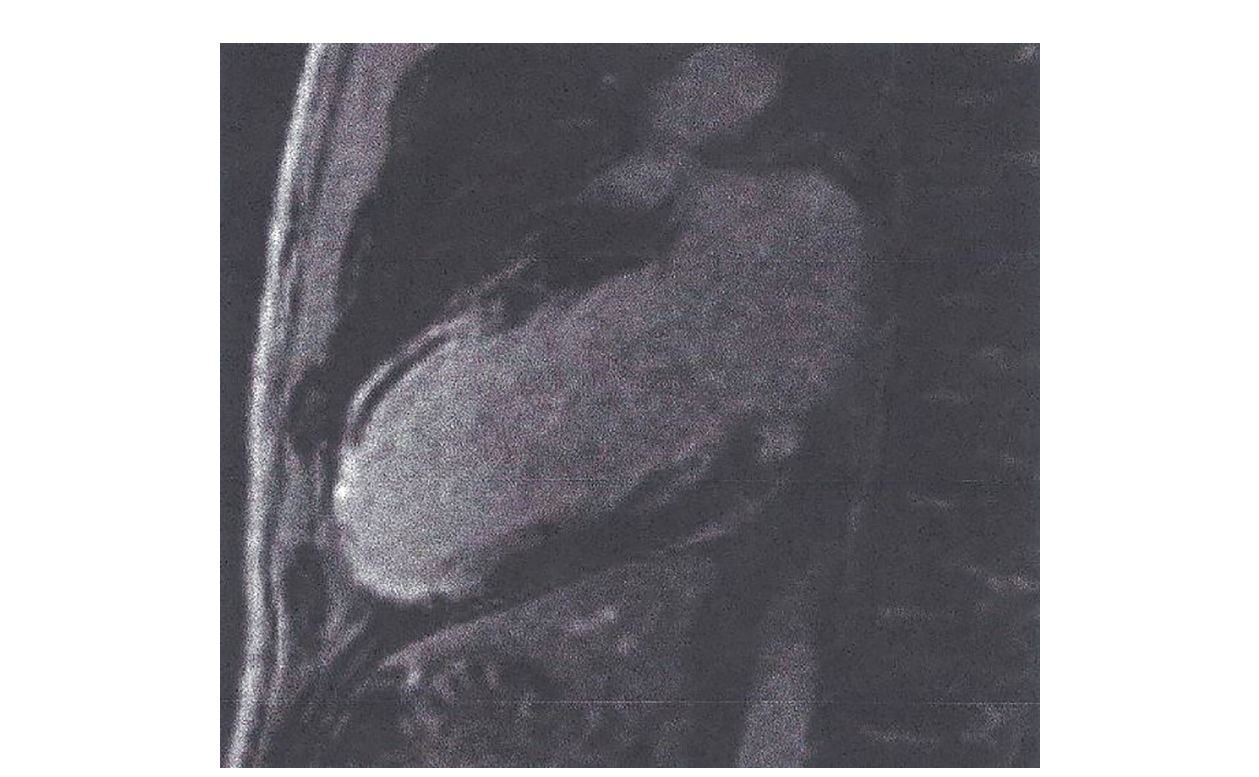
FIGURE 4 | LGE image showing extensive myocardial infarction in anterior wall (bright area) with microvascular obstruction (dark area within the white area of scar) in a patient with T2DM. This fi gure is original and based on data from Mavrogeni et